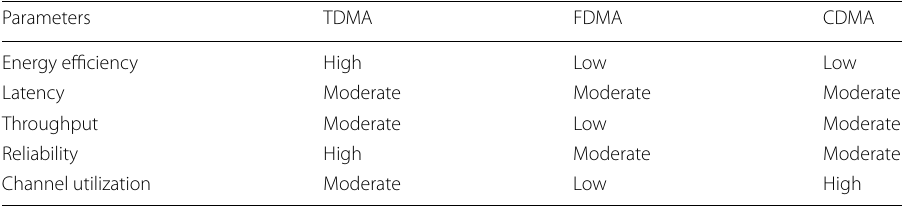
Table 2 Qualitative analysis of TDMA, FDMA, and CDMA protocols [25–28] Parameters TDMA FDMA CDMA Energy efficiency High Low Low Latency Moderate Moderate Moderate Throughput Moderate Low Moderate Reliability High Moderate Channel